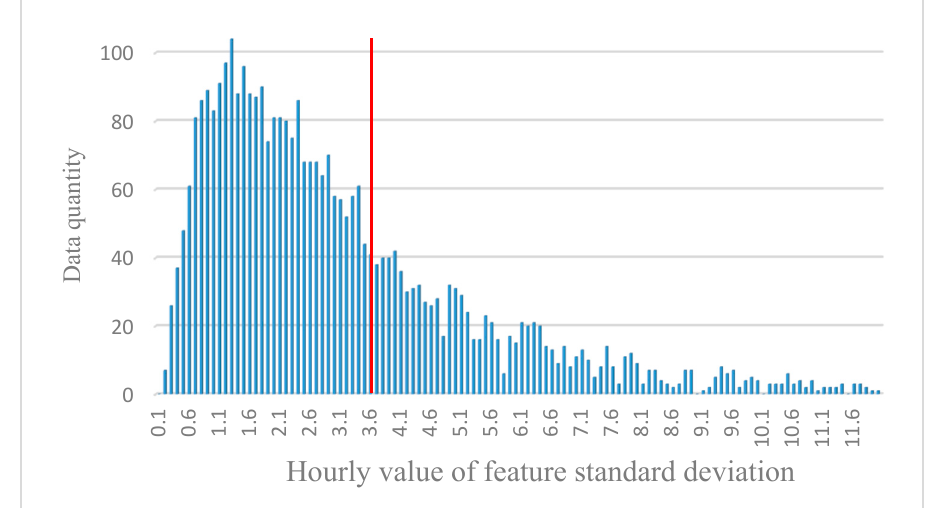
Figure 12. The standard deviation distribution of hourly feature